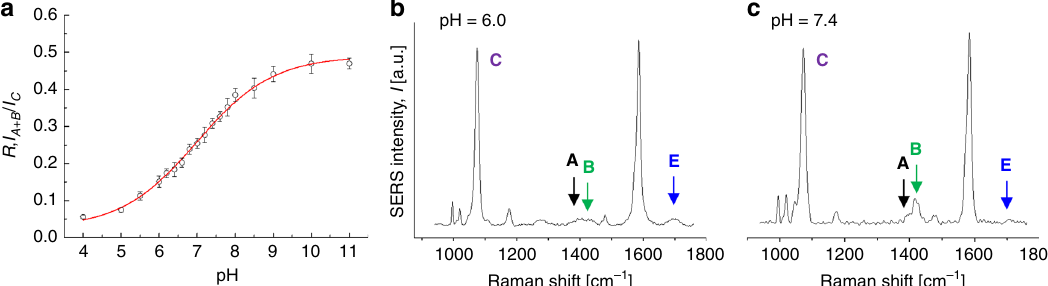
Fig. 7 SERS intensity response to the variation of pH. a Experimental calibration curve of ratio R = I A + B / I C as a function of pH (error bars show the standard deviation from the mean of n = 8 measurements). Source data are provided as a Source Data fi le. In b and c are reported two typical spectra collected from AuNP in solutions at pH 6.0 and 7.4. Positions of the intensities related to bands A, B, and E are indicated by arrows and labels. The deconvoluted band C was used to normalize the A + B intensity. In acidic environments, the intensity of COO − symmetric stretching (A + B) decreases, re fl ecting the reduction of deprotonated carboxylic acid concentration. In alkaline solutions, the intensity of this vibration mode increases, especially sub-band B. Compared to band A + B, band E due to C = O stretching vibration in COOH is less intense and it has an opposite trend of intensity as a function of pH. Source dataSource data